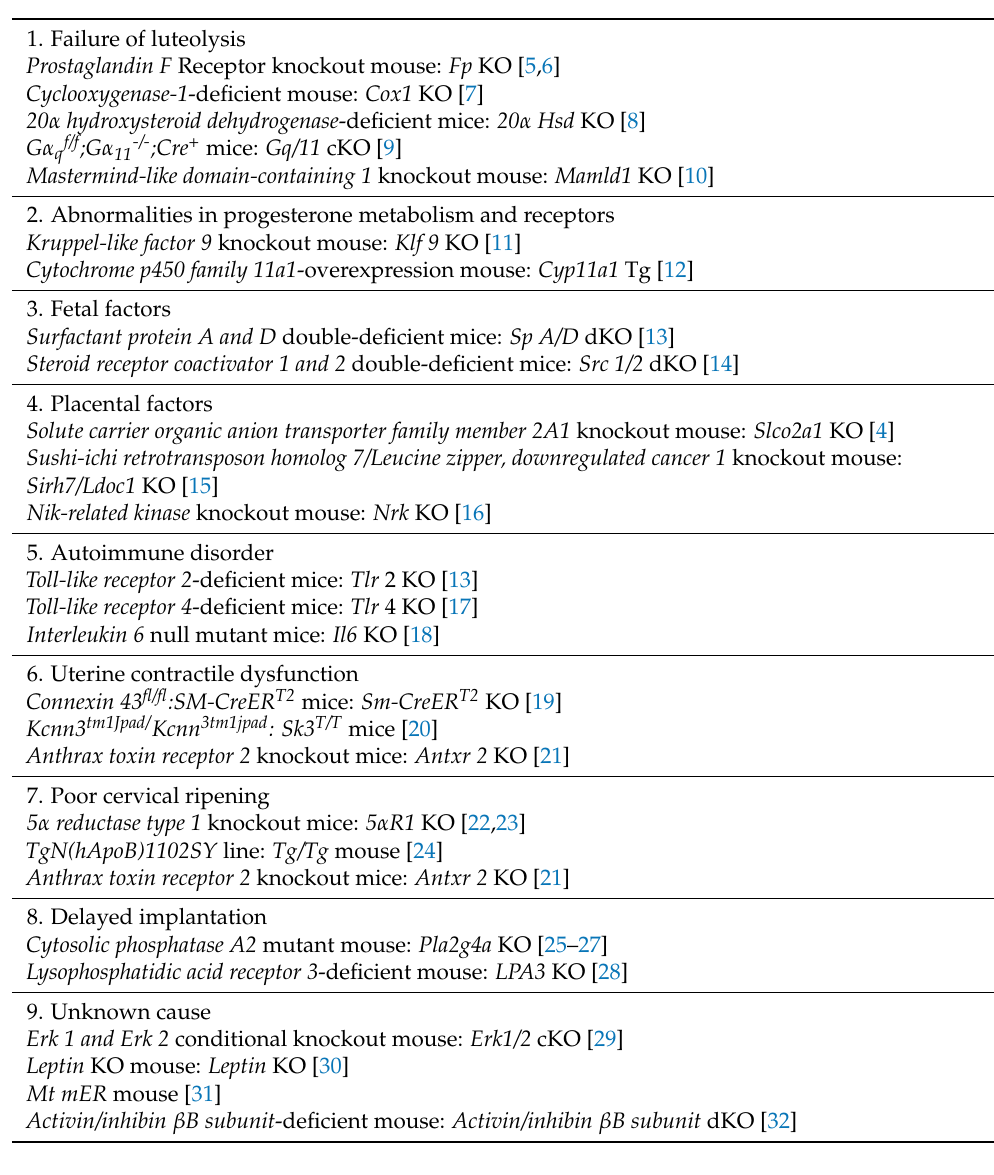
Table 1. Classification of genetically modified mice that exhibit delayed delivery (official name: abbreviation). We searched the literature published between 1970 and 2020, and classified the 26 mice according to the cause of delayed